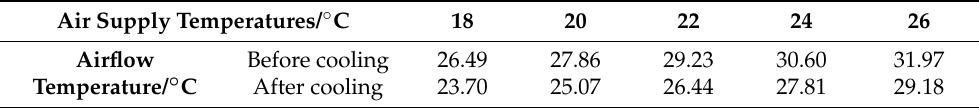
Table 3. Temperature of measuring point 3 under different air supply